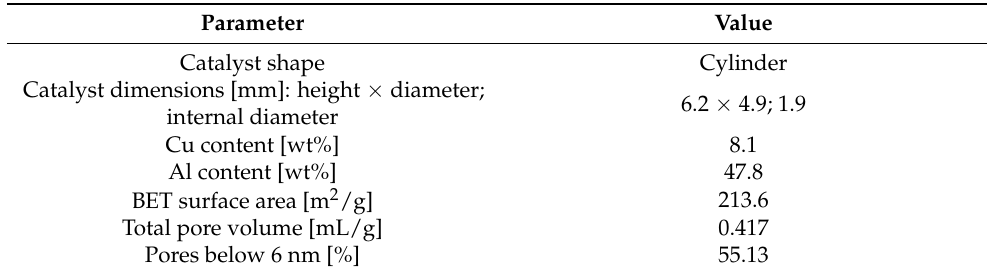
Table 6. Fresh Cu-based catalyst prepared with calcined support impregnated in a 10 wt% solution description, XRF analysis and BET analysis results.